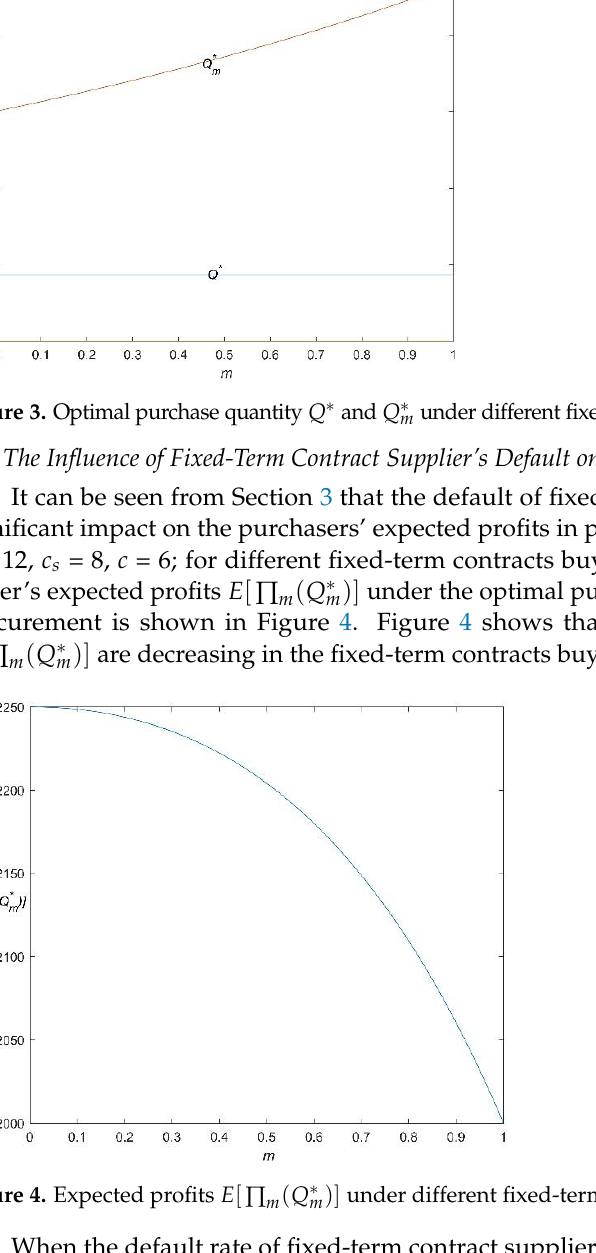
Q  )] ( E [ * under different fixed-term contracts supplier default rate m m